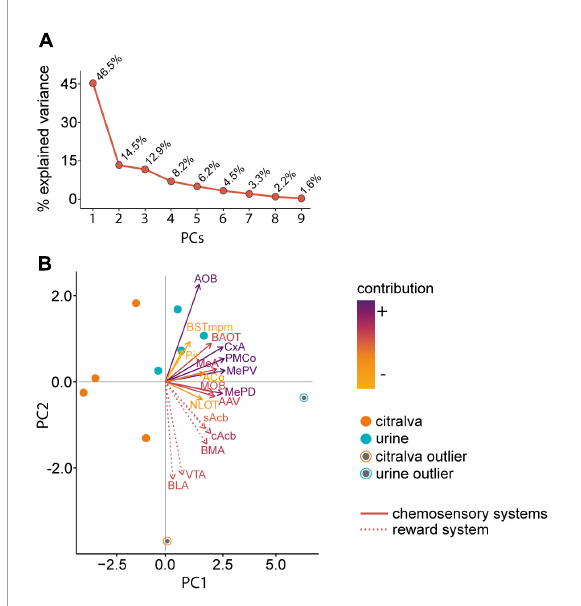
FIGURE10 Principal component analysis of the c-Fos cell density data in the chemosensory and reward systems. (A) Percentage of explained variance by each principal component. (B) PCA biplot showing females exposed to male urine (blue dots, n = 5) or citralva (orange dots, n = 5). Dots represent the loading of each animal to the PCs. Outliers, represented as black dots, were identified by the Mahalanobis distance method and left in the analysis. Solid vector lines represent chemosensory structures and dashed vector lines reward system nuclei. Darker color of the vector implies more contribution, whereas lighter color implies less contribution. The orientation of the vector indicates how much the variable contributes to the PC: the more parallel to a principal component axis, the more it contributes only to that PC. The length of the vector indicates how well the two principal components explain the variability of the density of c-Fos expression for that nucleus. The angles between vectors corresponding to different nuclei show their correlation: small angles represent high positive correlation, right angles represent lack of correlation, opposite angles represent high negative correlation. AOB, accessory olfactory bulb; MeA, anterior medial amygdaloid nucleus; MePD, posterodorsal medial amygdaloid nucleus; MePV, posteroventral medial amygdaloid nucleus; BAOT, bed nucleus of the accessory olfactory tract; PMCo, posteromedial cortical amygdaloid nucleus; AAV, anterior amygdaloid area ventral part; BSTmpm, medial posteromedial bed nucleus of the stria terminalis; MOB, main olfactory bulb; Pir, piriform cortex; CxA, cortex amygdala transition area; ACo, anterior cortical amygdaloid nucleus; NLOT, nucleus of the lateral olfactory tract; cAcb, nucleus accumbens core; sAcb, nucleus accumbens shell; VTA, ventral tegmental area;